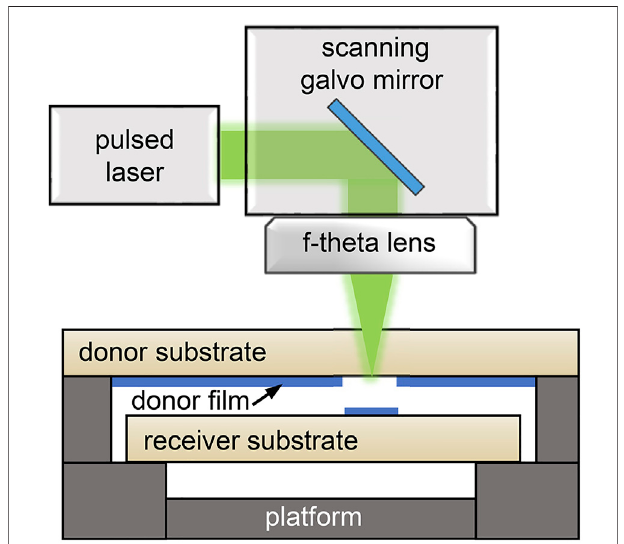
FIGURE 1 | Schematic diagram of the processing system used for the LIFT process.